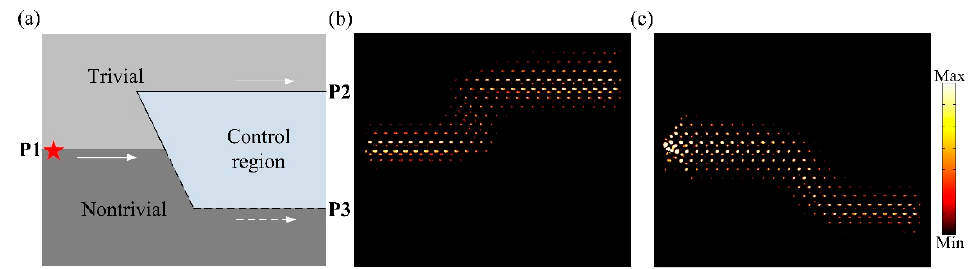
Figure 4. ( a ) Schematic diagram of the reconfigurable topological switch. The pedestals of the elliptical rods in the blue region are attached to computer-controlled motors by which the elliptical rods could be rotated to di ff erent angles. ( b , c ) Electric field intensity distributions when switched between the di ff erent topological states. The electromagnetic (EM) waves transmitted through port 2 (or port 3) at the rotation angle 0 ◦ ( 90 ◦ ) of the reconfigurable control region (highlighted in blue, in ( a )). Perfectly matched layers were imposed to the surrounds of the whole PC structures to absorb output wave.